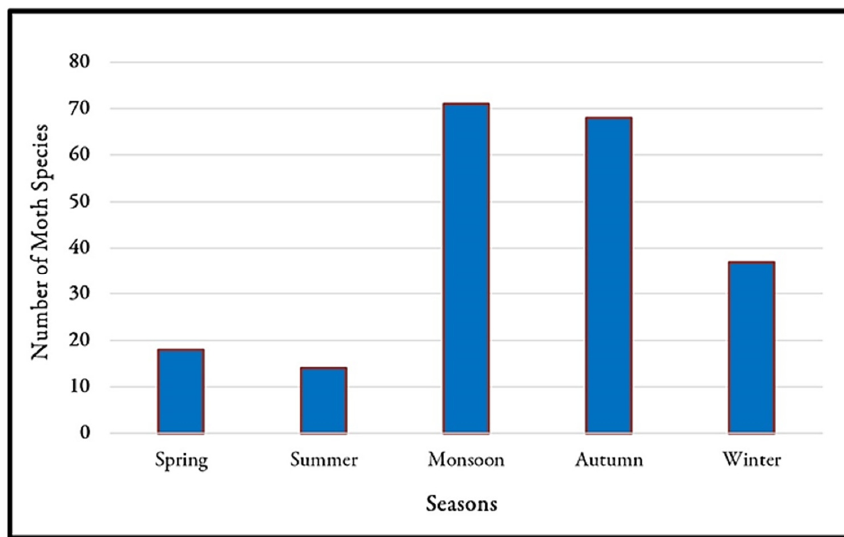
Figure 5. Seasonal distribution of recorded moth